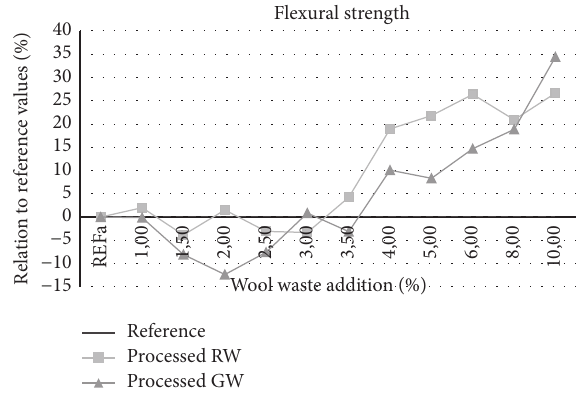
Figure 11: Compressive strength comparison between the series and the reference